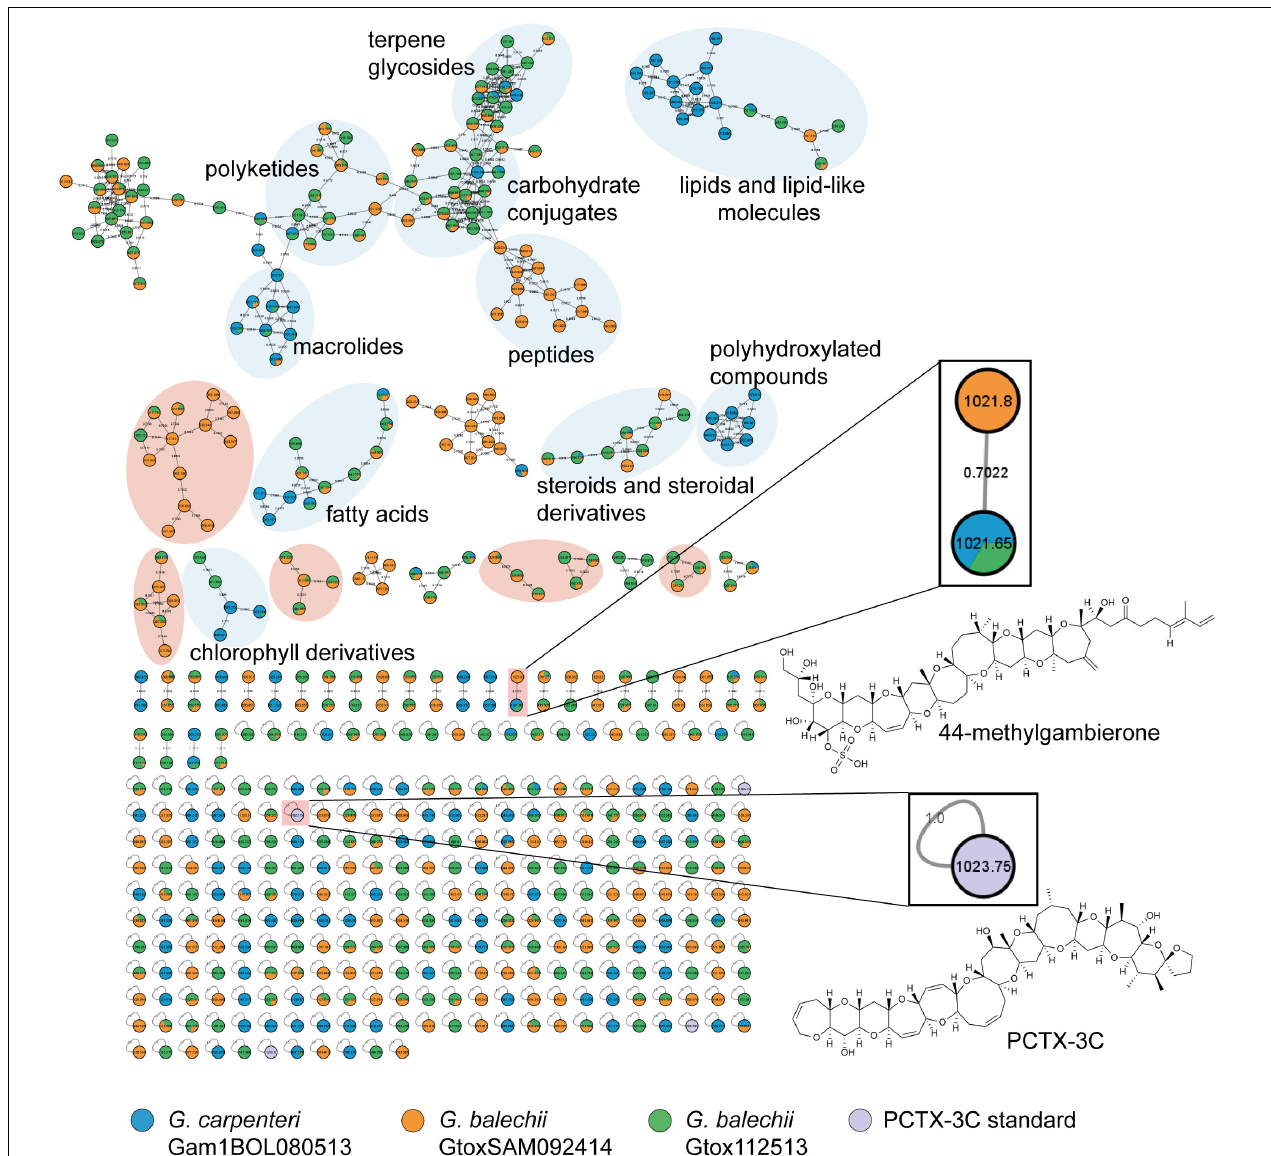
FIGURE 6 | Molecular network generated from HRMS/MS spectra from the Florisil R (cid:13) fractions of three Gambierdiscus strains, and P-CTX-3C standard using Global Natural Product Social Molecular Networking (GNPS) tool. Each node corresponds to a compound in the given strain (indicated by the color/s of the node). The nodes were color-coded according to the strains: G. carpenteri Gam1BOL080513 in blue, G. balechii GtoxSAM092414 in orange, G. balechii Gtox112513 in green, and the P-CTX-3C standard in lavender. Similarity between nodes is represented by the gray curves labeled by the cosine score. Annotation of compound class or family was performed through matching of fragmentation patterns of known compounds available in the GNPS server. Enlarged inset are manually annotated toxins, authentic standard (P-CTX-3C) and 44-methylgambierone with their chemical structures. The three Gambierdiscus strains contain 44-methylgambierone and chemically diverse secondary metabolites. A high-resolution image of the molecular network is provided in the Supplementary Material ( Supplementary Figure 1